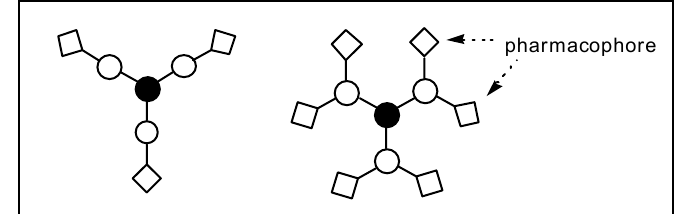
Figure 4. Dendrimers appended with multiple pharmacophore